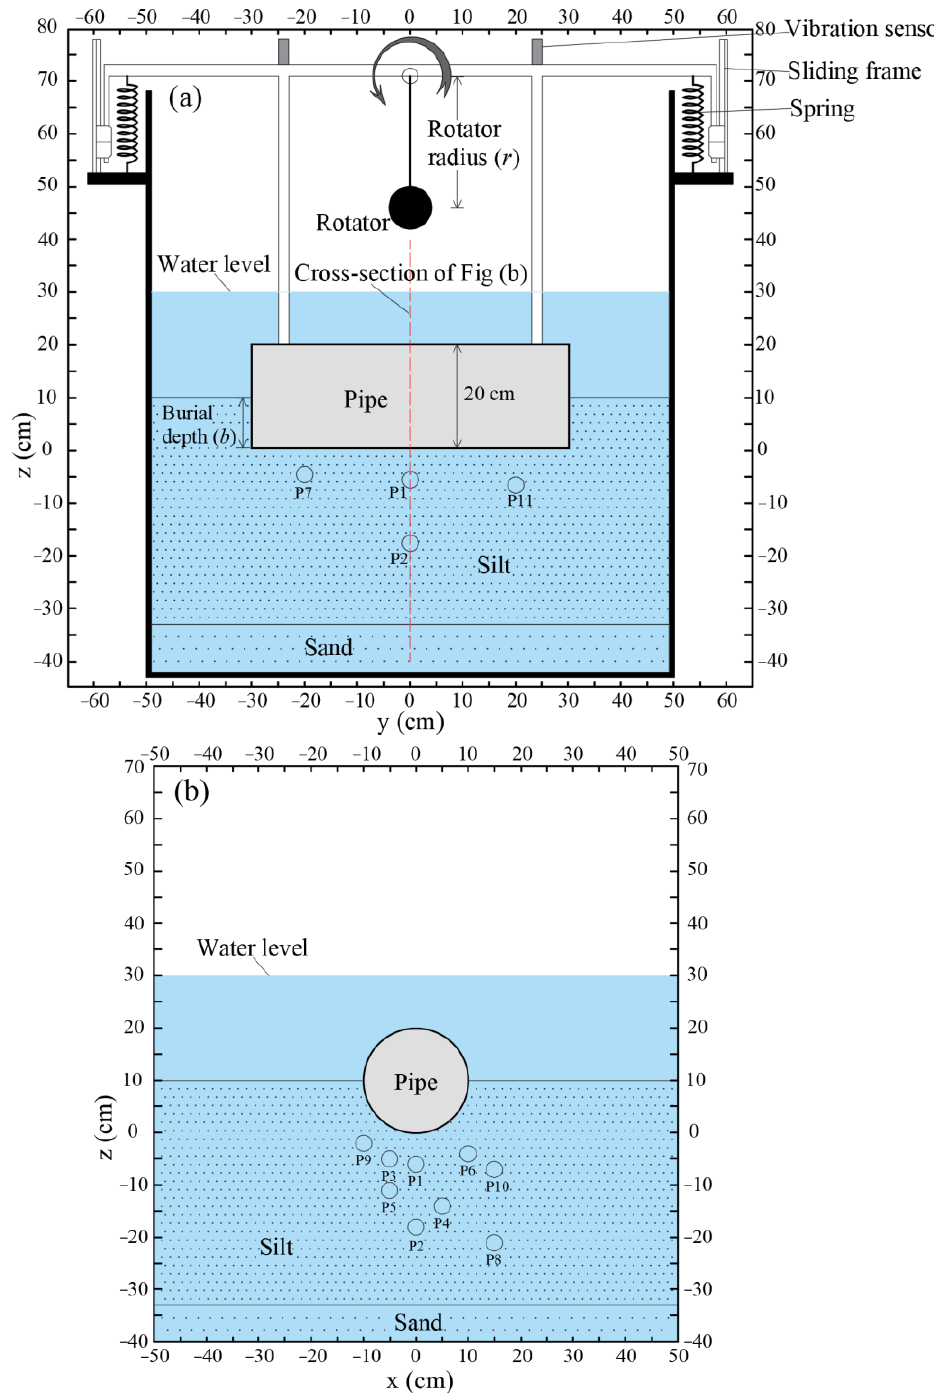
Figure 2. ( a ) Experimental set up. ( b ) Location of pore-water pressure sensors, designed to have varying distances from the pipeline center. The coordinates of each sensor are p1 (0, 0, −6 ); p2 (0, 0, −1 8); p3 ( −5 , 0, −5 ); p4 (5, 0, −1 4); p5 ( −5 , 0, −1 1); p6 (10, 0, −4 ); p7 (0, −2 0, −5 ); p8 (15, 0, −2 1); p9 ( −1 0, 0, −2 ); p10 (15, 0, −7 ); and p11 (0, 20, −7 ).